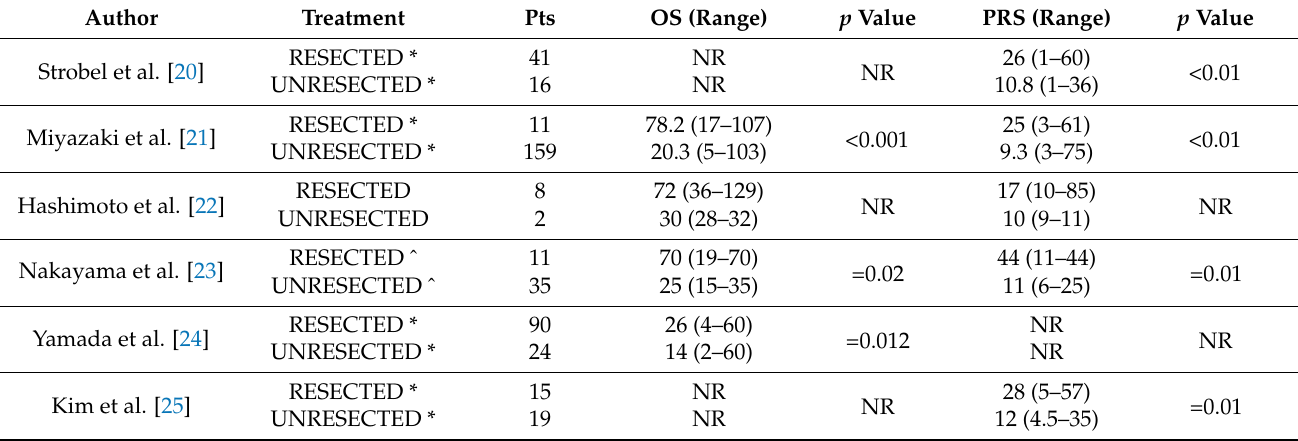
Table 1. Studies included in the meta-analysis. OS and PFR are compared for each study (significant difference for p value < 0.05). Pts: number of patients; OS: overall survival; PRS: post recurrence survival; * extrapolated from K-M plot; ˆ extrapolated from confidence interval; NR: not